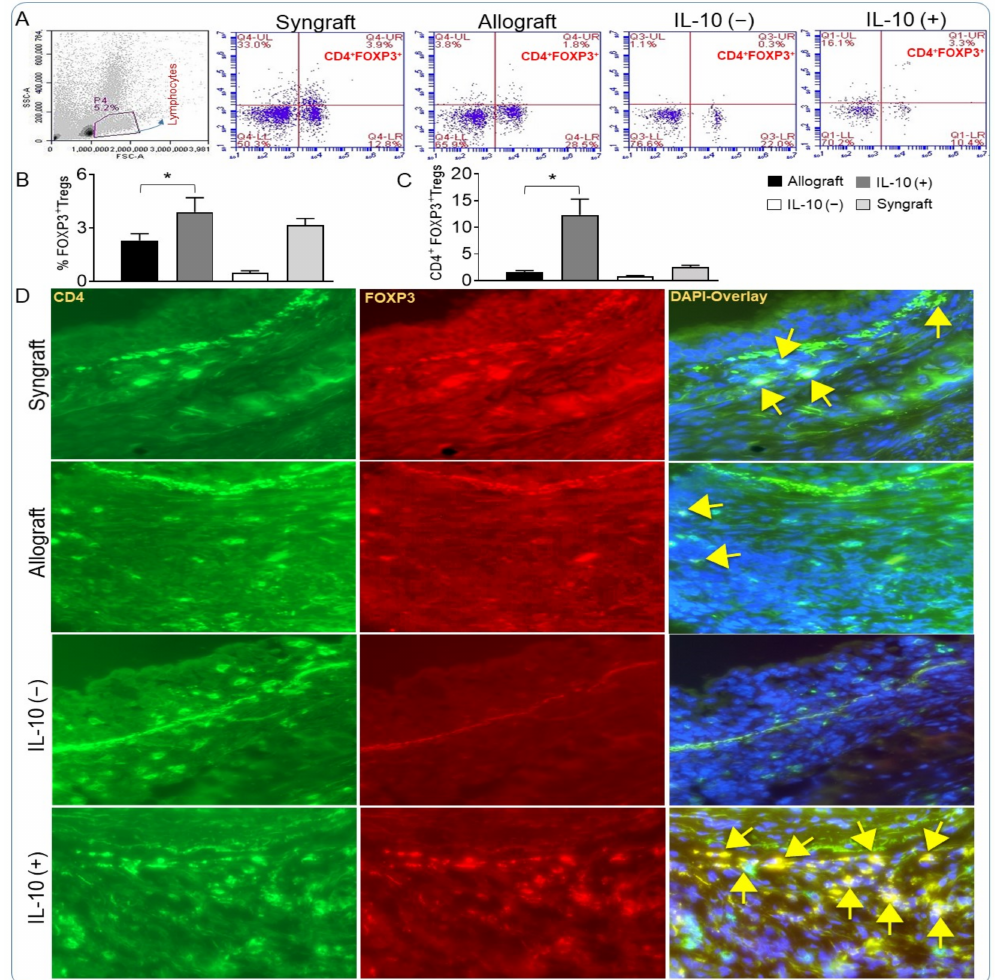
Figure 1. IL-10 is sufficient to establish immunotolerance in rejecting allograft. Flow cytometry analysis of Tregs from peripheral blood of transplants at d10 post-transplantation: ( A , B ) Percentage of gated lymphocytes and semi-quantitative analysis of FOXP3 + T cells in a given gated lymphocyte population. ( C , D ) Semi-quantitative analysis and immunofluorescent staining of CD4 + FOXP3 + co-expression at d10 post-transplantation. Yellow arrows highlight CD4 + FOXP3 + Treg cells. Data are presented as means with SE of 16 transplants/time point/experiment. * p < 0.05. Original magnification, ×